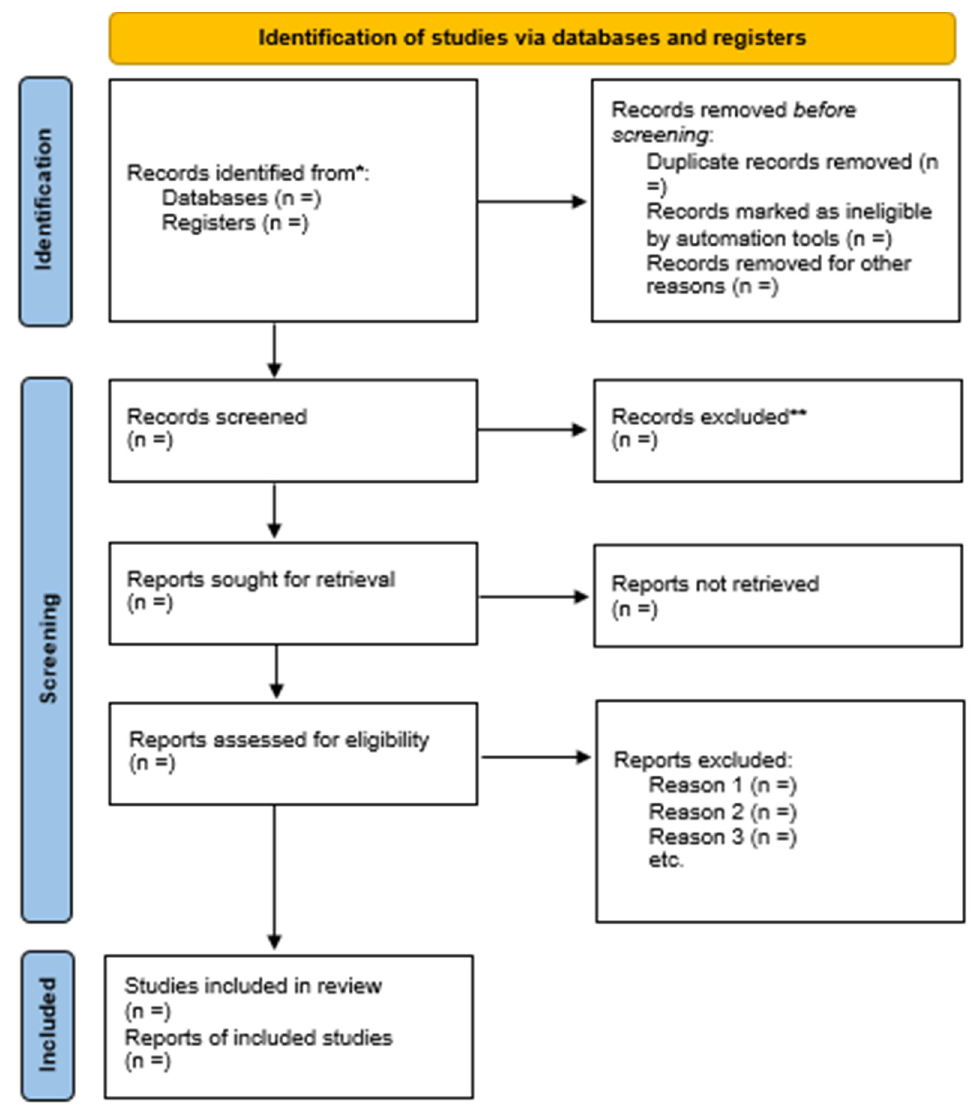
Figure 1. PRISMA flow diagram of the study selection process. PRISMA, Preferred Reporting Items for Systematic Reviews and Meta-Analyses. * Consider, if feasible to do so, reporting the number of records identified from each database or register searched (rather than the total number across all databases/registers). ** If automation tools were used, indicate how many records were excluded by a human and how many were excluded by automation tools. From: Page, M.J., McKenzie, J.E., Bos-